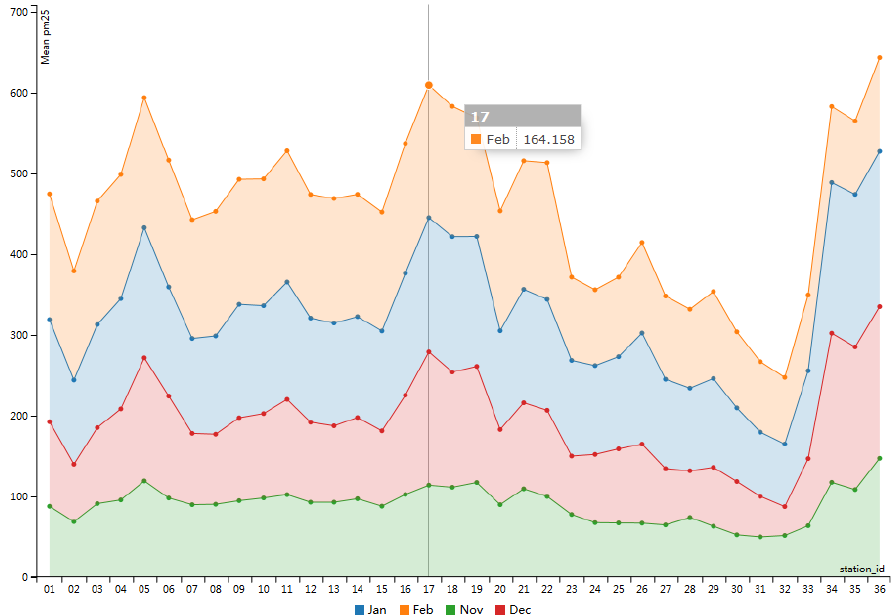
Figure 6. Area chart displaying the mean AQI of PM 2.5 on each observation site (id: 01–36) in January,